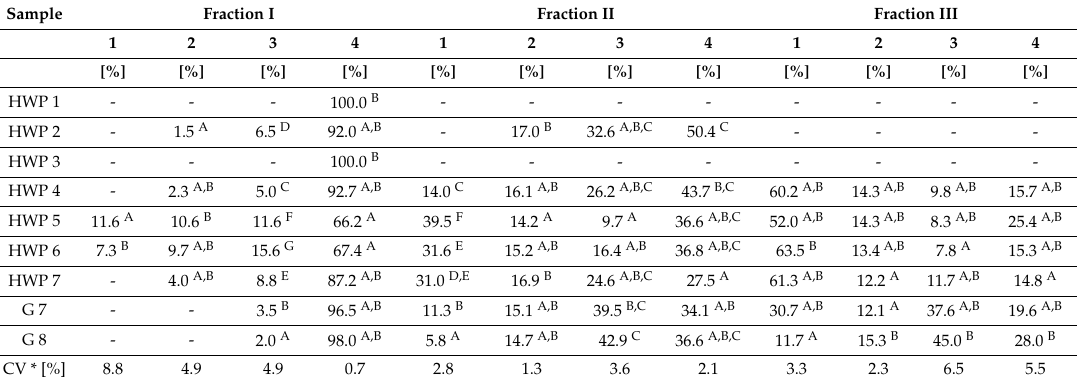
Table 2. Gel-permeation HPLC (system I): Analysis of fractions I, II, and III of treated gluten (G7 and